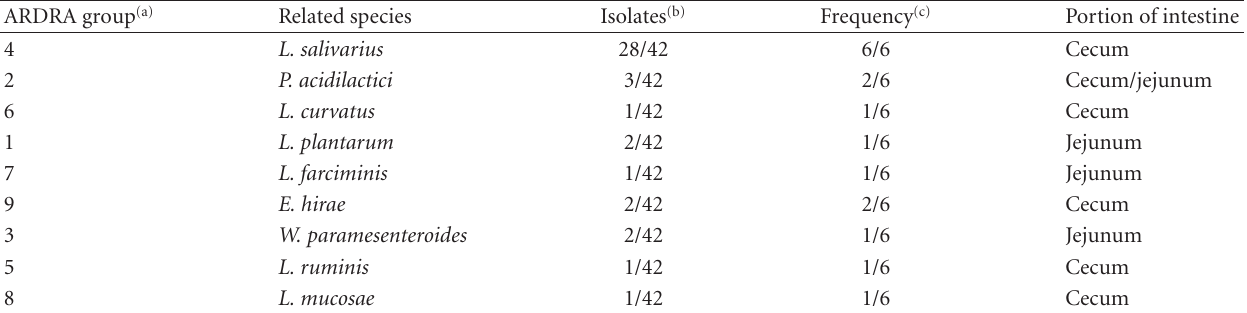
Table 2: Number of isolates for each ARDRA group; frequency of occurrence of each species and portion of the intestine in which the isolates were obtained.